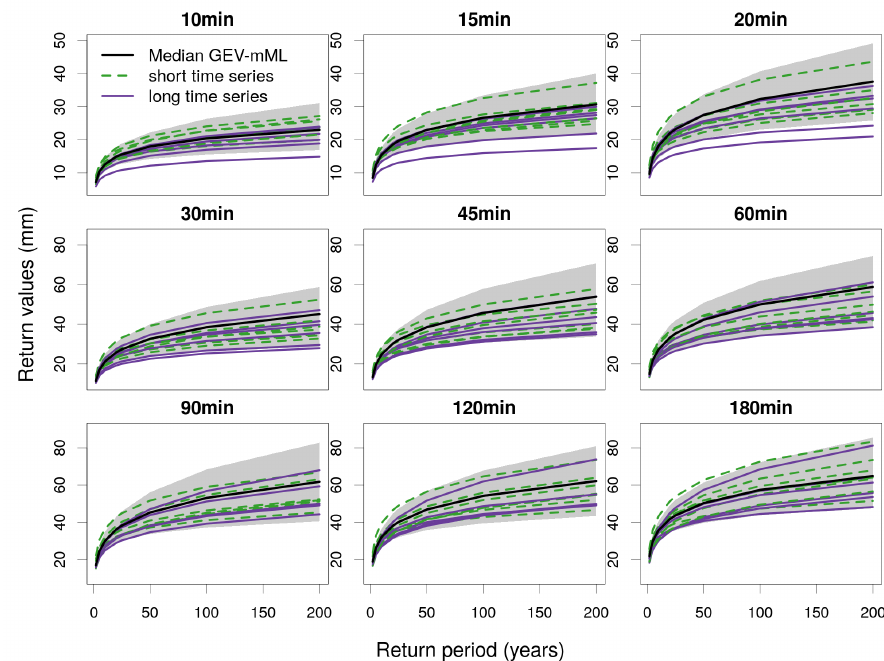
Figure 7. Confidence interval (grey) and median (black) of return values for Oslo-Blindern station (18701), estimated with GEV-mML. Median values for the other stations are shown as green dashed lines if the observed time series is shorter than 20 years, and as purple solid lines if observations are longer than 20 years.